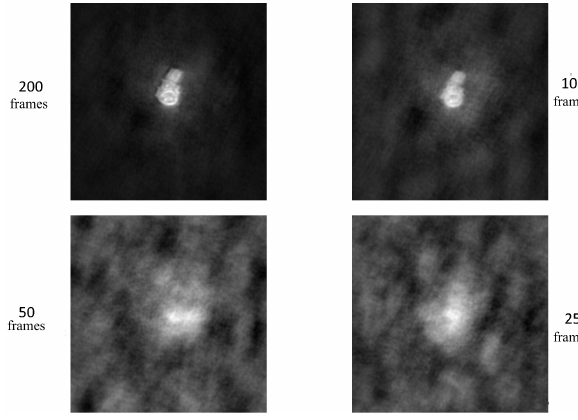
Figure 11. Restored images (point-spread functions – star